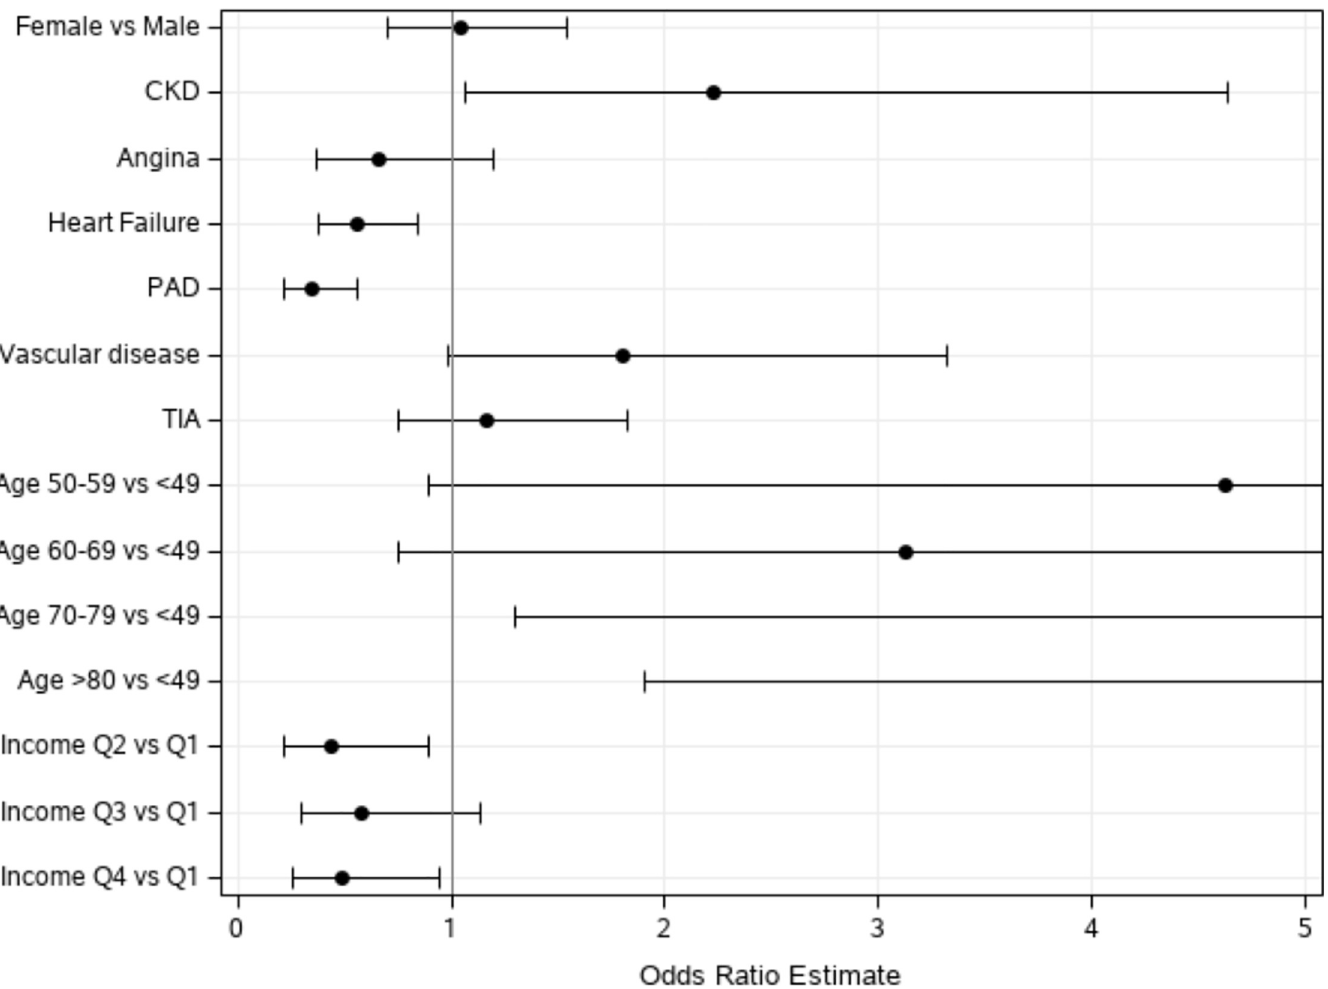
Fig 5. Multivariate regression analysis for underuse of OAC in patients with atrial fibrillation � . � CHA 2 DS 2 -VASc score � 2 before acute ischemic stroke events were taken into account.